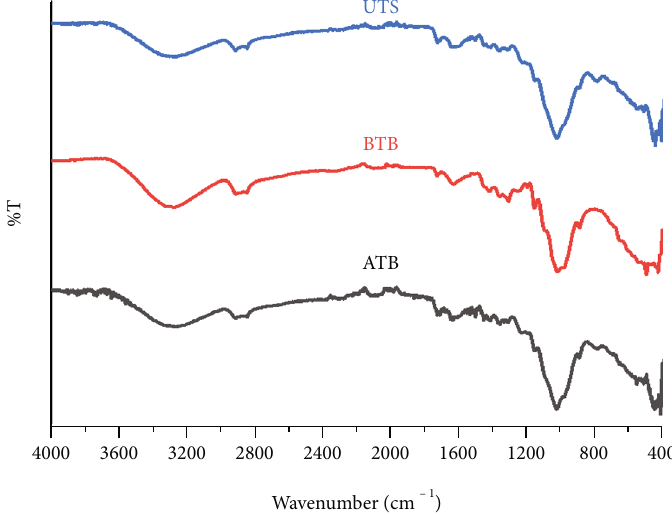
Figure 3: FTIR spectral of the raw and treated Te ff